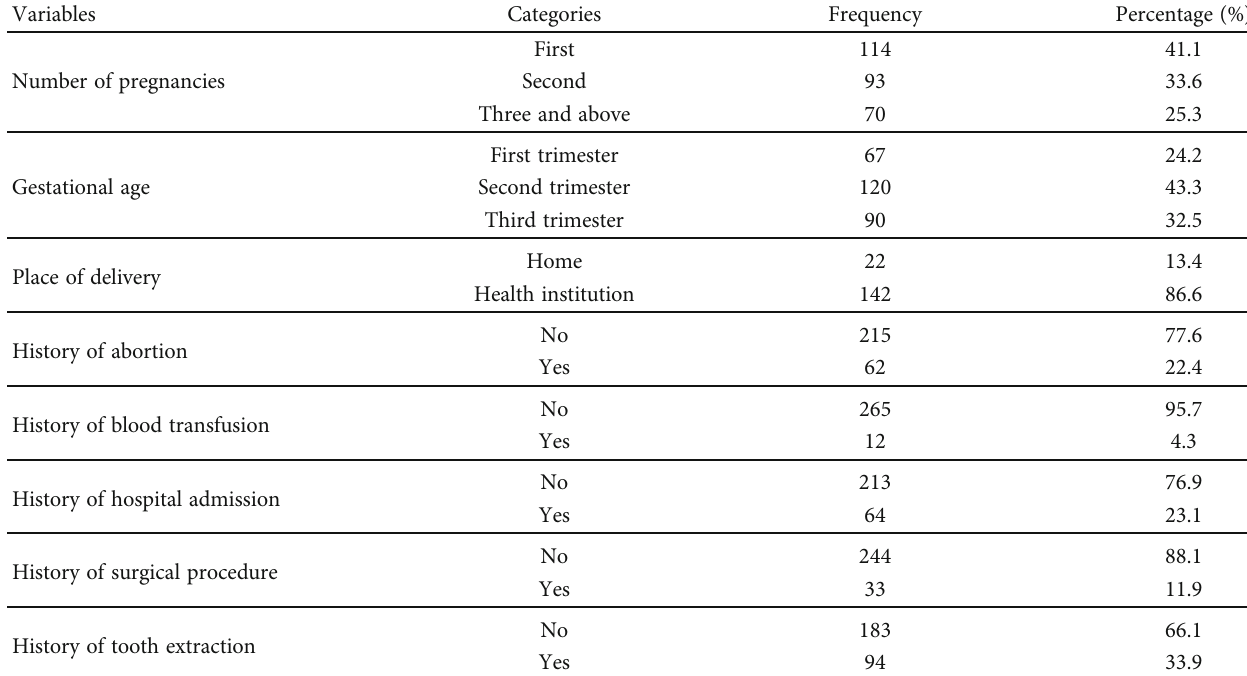
Table 2: Obstetric and other health service-related factors among pregnant women attending ANC at public health facilities in Nekemte town, Western Ethiopia,